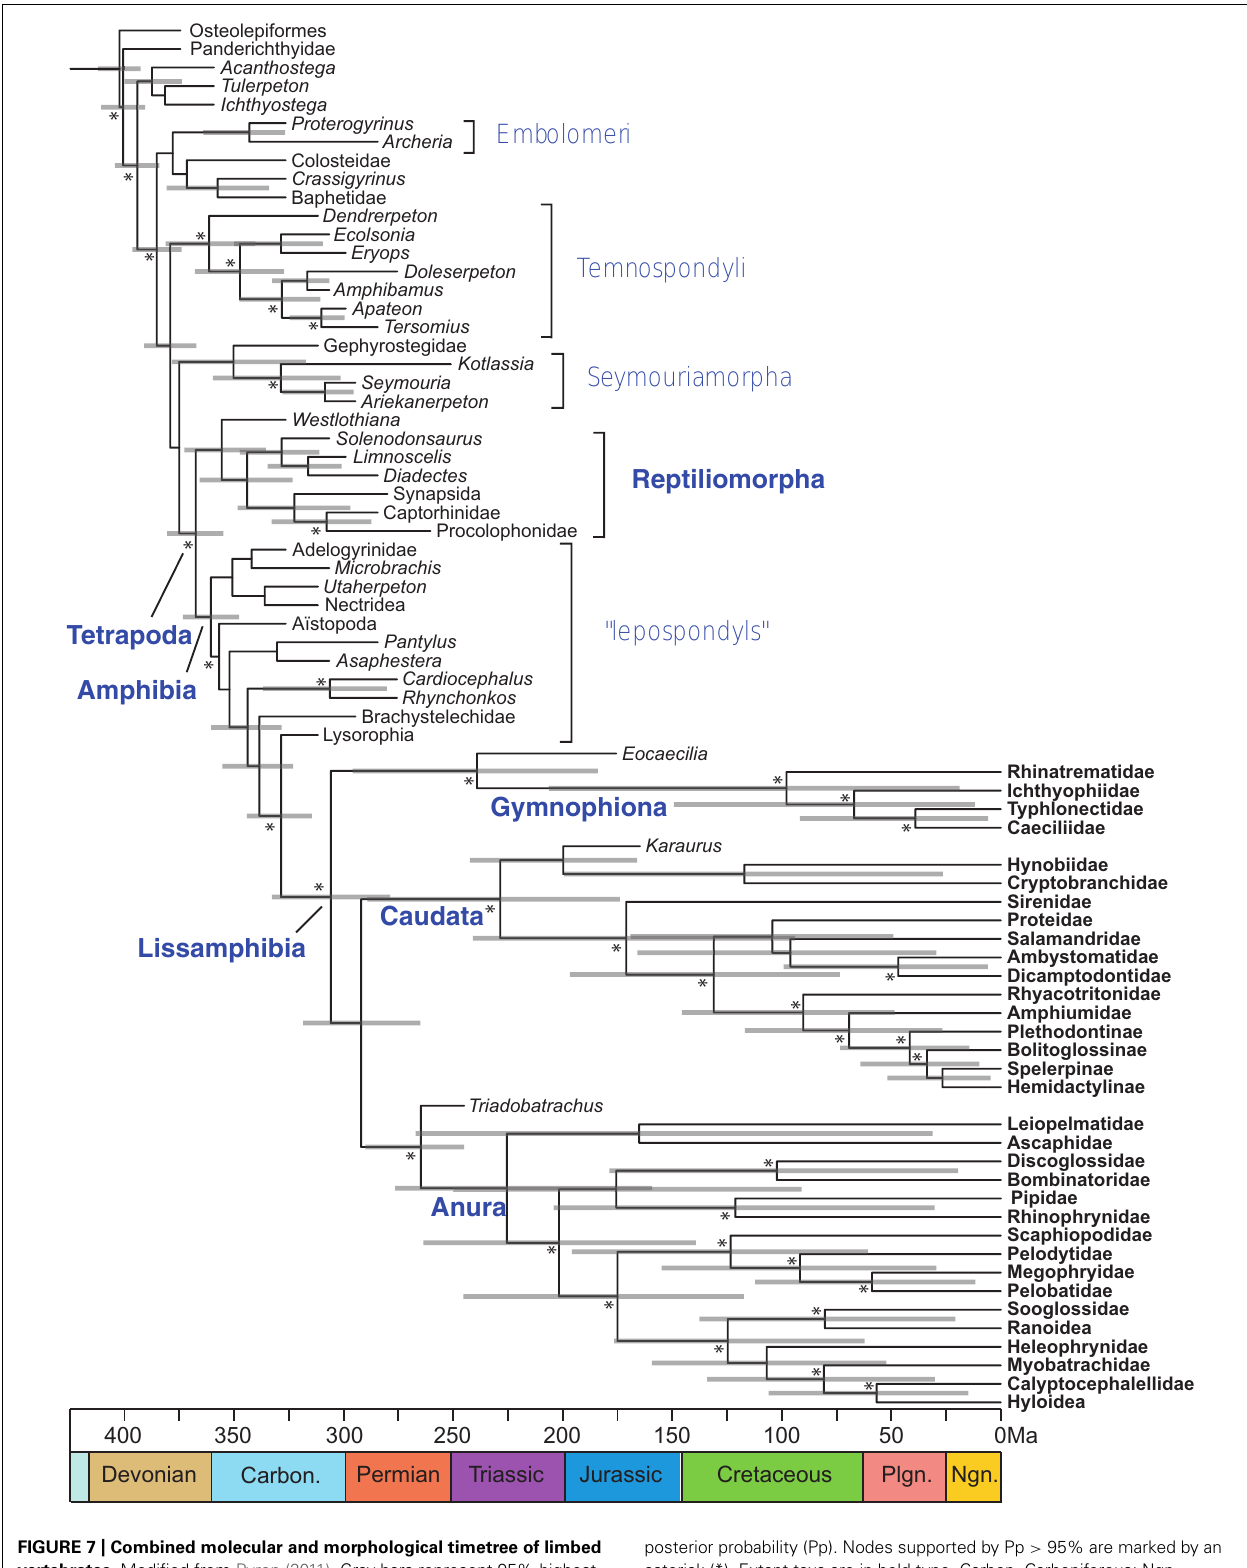
posterior probability (Pp). Nodes supported by Pp > 95% are marked by an asterisk (*). Extant taxa are in bold type. Carbon, Carboniferous; Ngn, Neogene; Plgn,